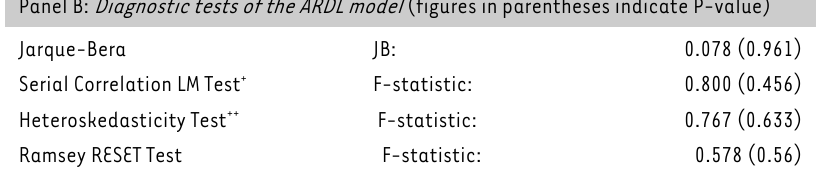
Panel B: Diagnostic tests of the ARDL model (figures in parentheses indicate P-value)